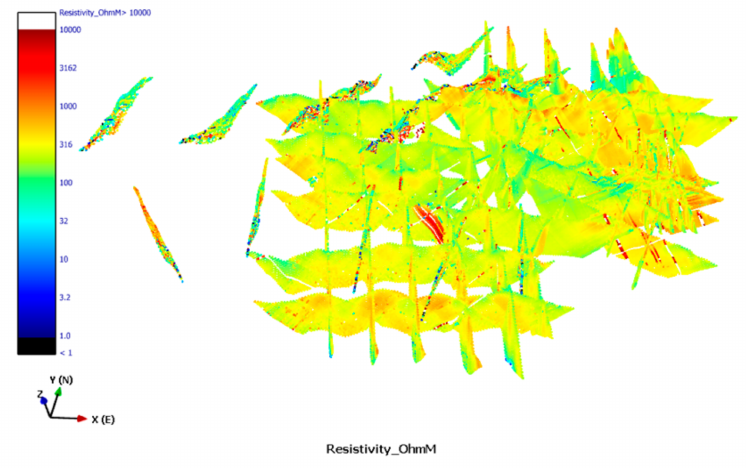
Figure 4. Result of electrical resistivity survey in the study